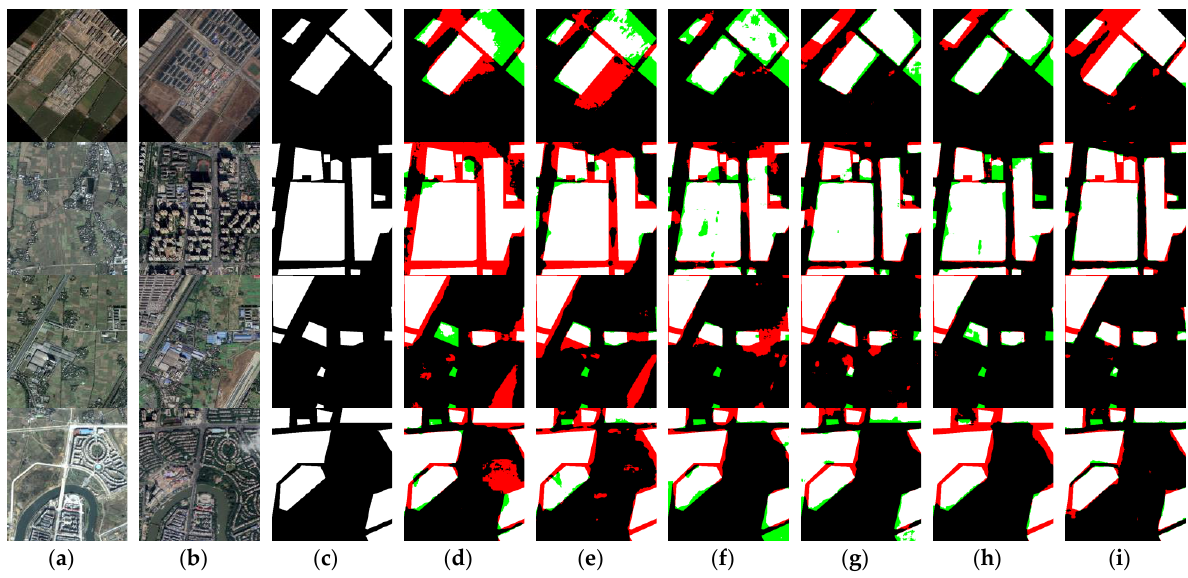
Figure 12. Visual comparison results on DSIFN dataset: ( a ) Image T1; ( b ) Image T2; ( c ) ground truth; ( d ) FC-Siam-conc; ( e ) U-Net++; ( f ) DASNet; ( g ) STANet; ( h ) SNUNet; ( i ) MCCRNet.